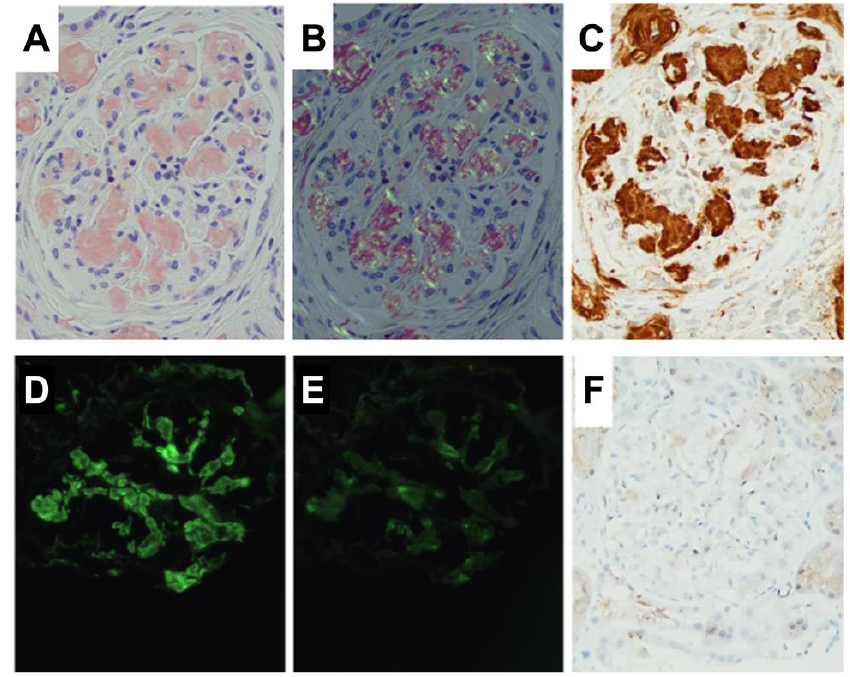
Figure 2. Renal amyloidosis. ( A ) Glomerular and arteriolar deposits of amyloid identified as Congo red-positive material (magnification 400×). ( B ) Glomerular amyloid Congo red-positive deposits showing birefringence under polarized light (magnification 400×). ( C ) AA amyloidosis: the im- munohistochemical stain for amyloid A is strongly positive in the glomerulus and in the arterioles (magnification 400×). ( D ) AL amyloidosis: by immunofluorescence, a glomerulus containing Congo red-positive material (not shown) shows a positive stain for the kappa light chain (magnification 400×). ( E ) The immunofluorescence stain for lambda light chain is negative in the same glomerulus (magnification 400×). ( F ) The immunohistochemical stain for amyloid A is negative in the glomeruli containing deposits of AL amyloid. 2.2. Raman Spectroscopy A Raman spectroscopy system (Horiba Jobin Yvon-XploRA PLUS) collected Raman spectra of ex vivo kidney tissue samples (Figure 1b). A 532 nm laser was projected onto room-temperature kidney sections, and the resulting Raman scattering between 700 and 3500 cm −1 was recorded through a CCD camera. Measurements were taken at various pathological sites, including glomeruli and other structures within the cortical region. The collected Raman spectra were processed using MATLAB 2018b (MathWorks, Inc., Natick, MA, USA) with baseline and background correction [38], spectral smoothing through a Savitzky-Golay filter [39], and normalization based on water content (3100 – 3400 cm −1 ). For multivariate and machine learning analysis, the biological fingerprint region (800 – 1800 cm −1 ) was selected, which contains molecular information including proteins, lipids, and other tissue constituents. 2.3. Data Analysis The collected Raman spectroscopic signals were examined to identify spectral fea- tures unique to a particular amyloid type. Second derivative analysis, which has been used to estimate the contribution of pro- tein secondary structure [29,40], was applied to identify spectral features arising from am- yloid fibrils within tissues. Second derivative spectra were obtained by the Savitzky-Go- lay filter [39], followed by robust locally weighted smoothing.